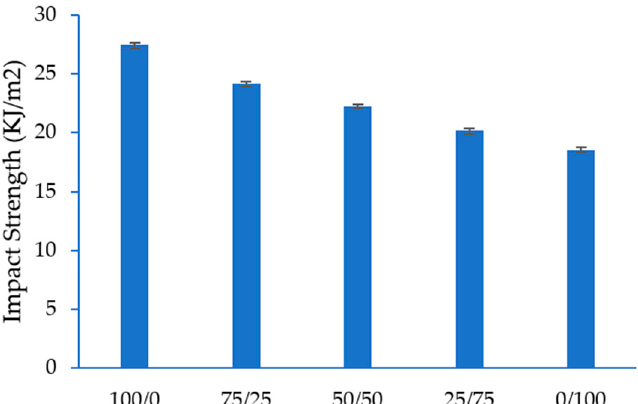
Figure 6. Impact Strength test result of enset–sisal hybrid composites.